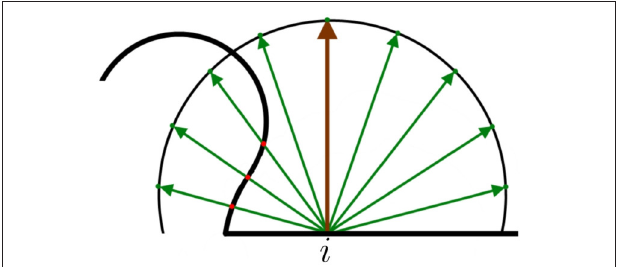
FIGURE 3 | Example of 2D ambient occlusion. The surface of the mesh is the thick black line. The brown line denotes the normal vector of the evaluated vertex i . A hemisphere is placed around the normal vector. The green lines represent the sampled N points of the hemisphere. The red dots are the intersection between the rays and the mesh surface. In this case, occlusion factor = 3 8